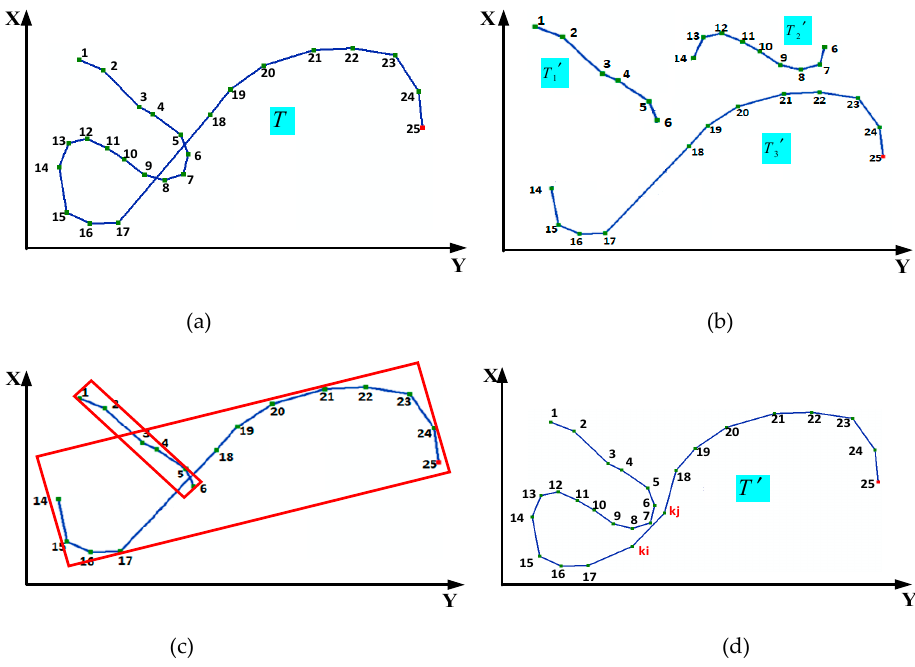
Figure 3. ( a ) The curve T which processed by D–P algorithm; ( b ) three monotonic chains T 1 (cid:48) , T 2 (cid:48)